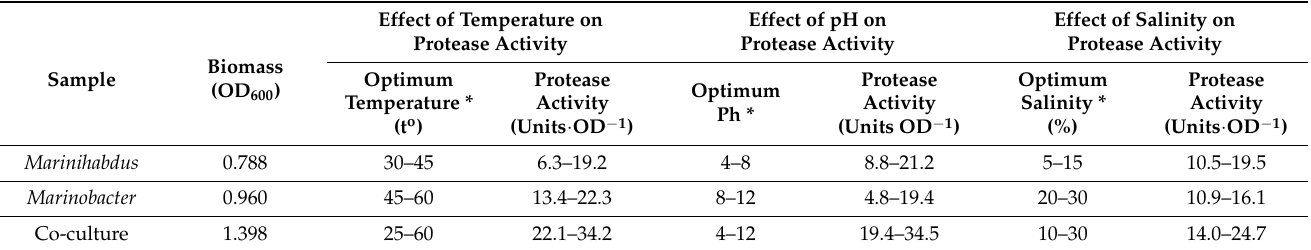
Table 2. The efficacy of coculture compared to